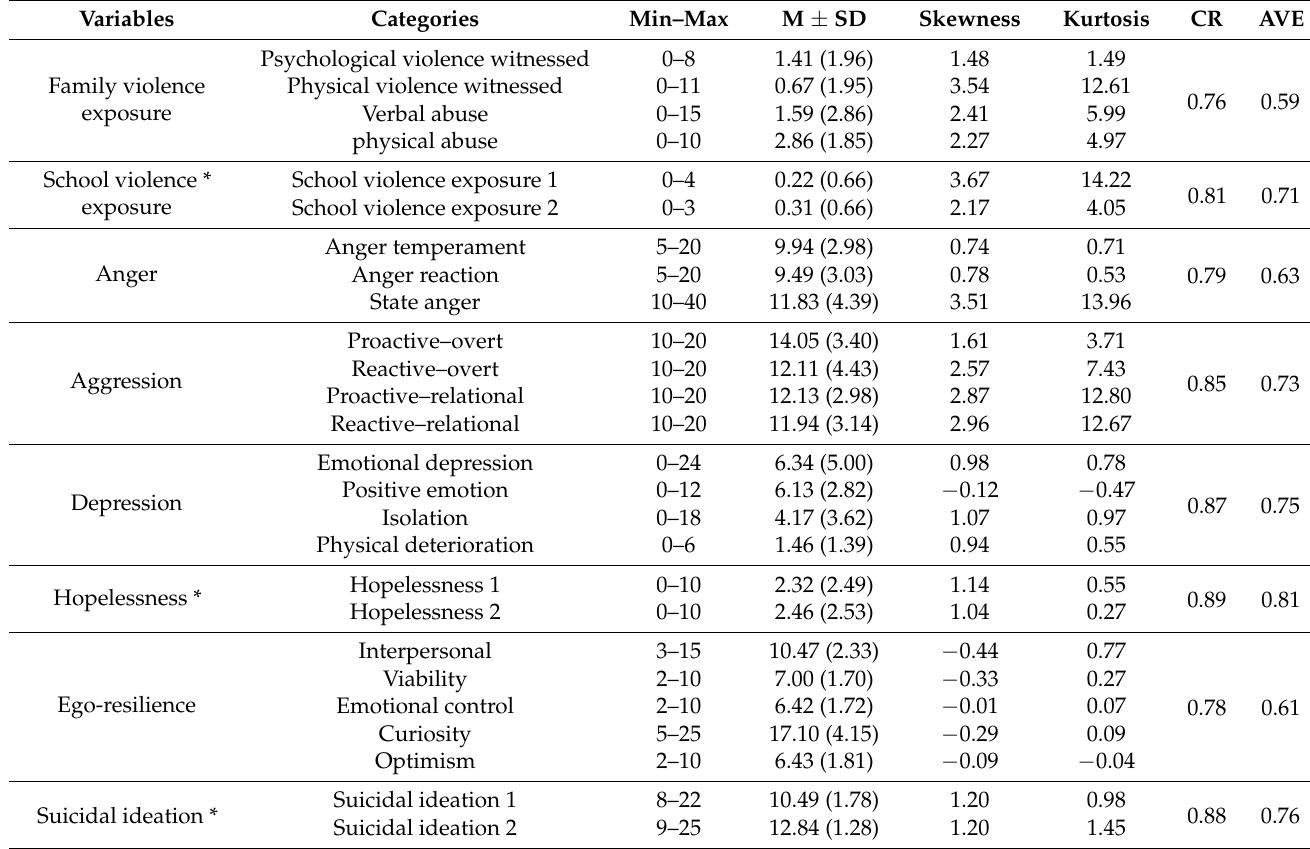
Table 1. Descriptive statistics of selected variables ( n =